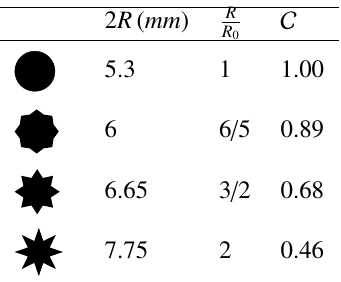
Table 1. Parameters of the 2D grains employed for the study of the shape e ff ect on the granular dynamics and their parameters. R being the outer radius of the shape, R 0 the inner radius and C its circularity.